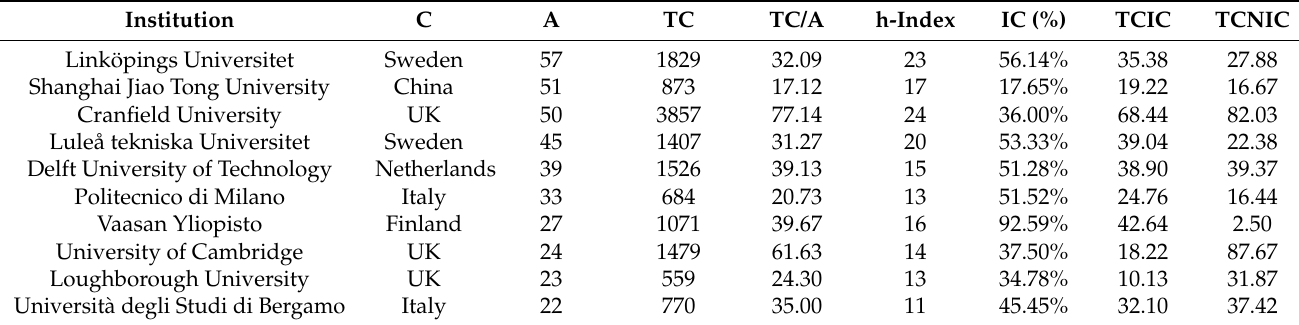
Table 4. Characteristics of the most outstanding institutions.